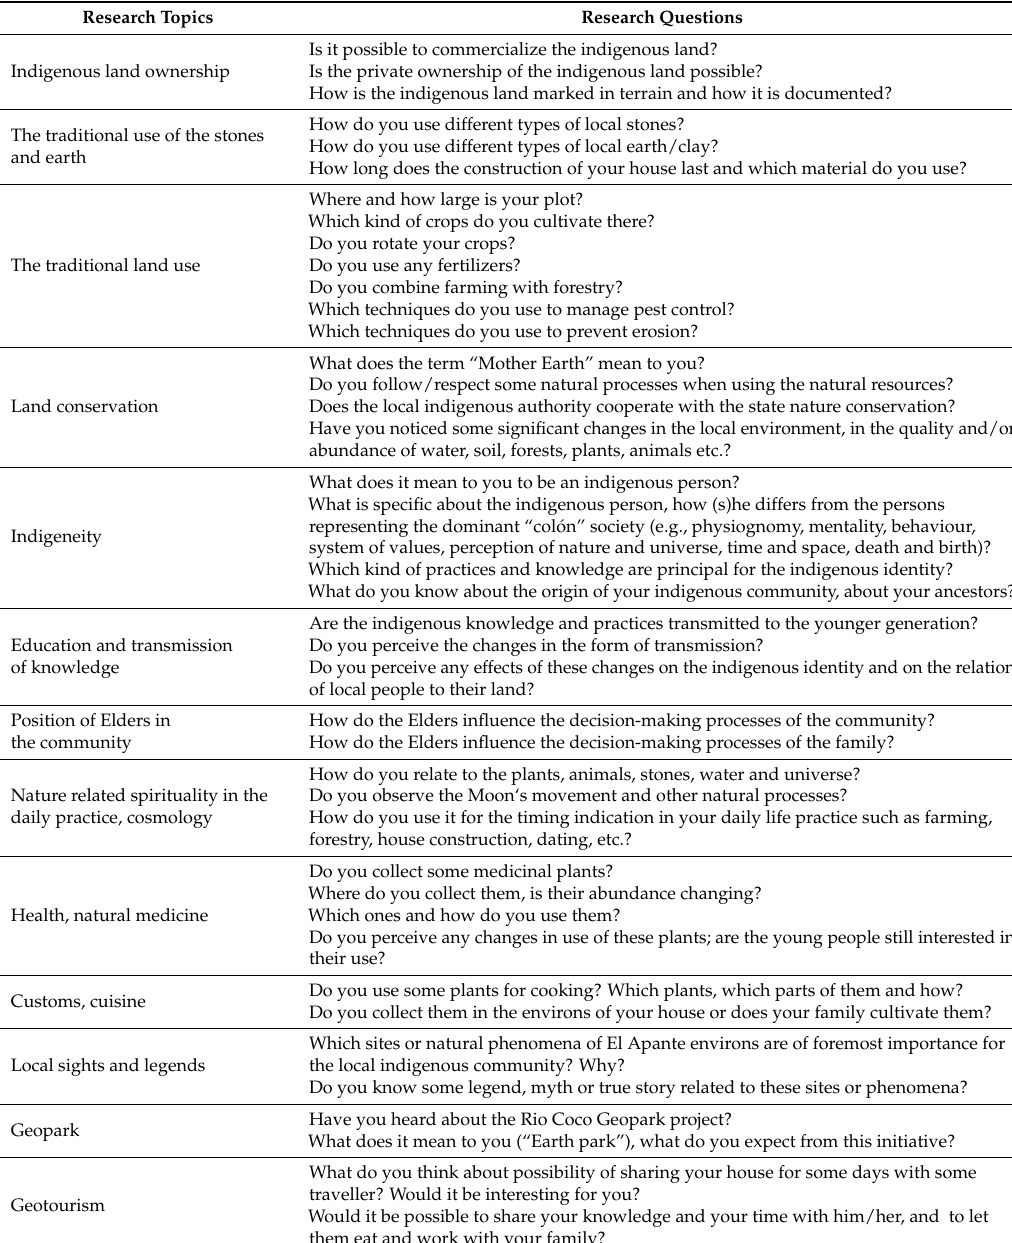
Table 1. The research topics and related interview